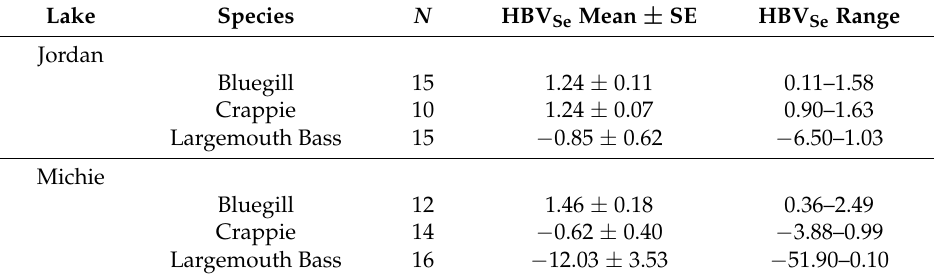
Table 4. Sample size ( N ), Se health benefit value (HBV Se ) mean ± standard error (SE), and range for three sportfish species from two reservoirs in central North Carolina,